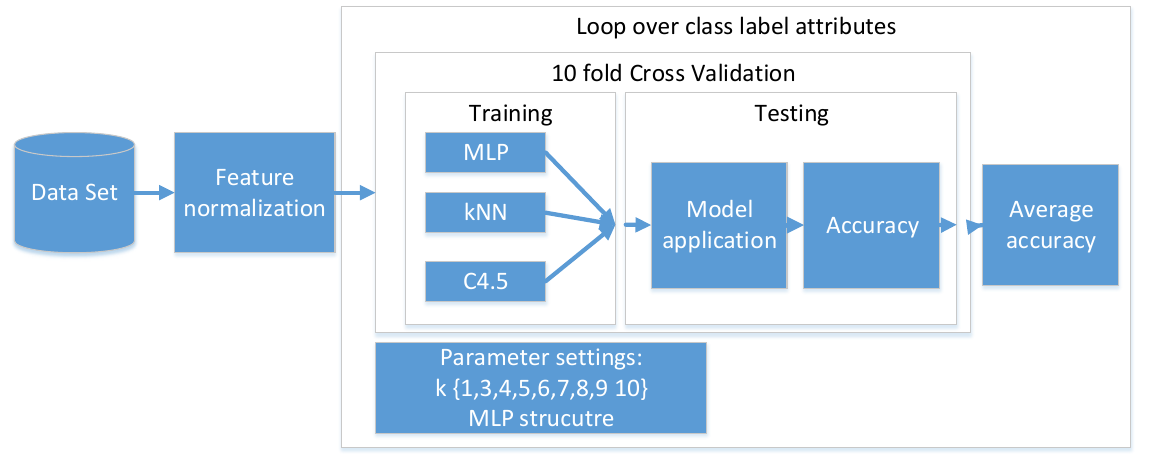
Fig. 5. Structure of the data mining process